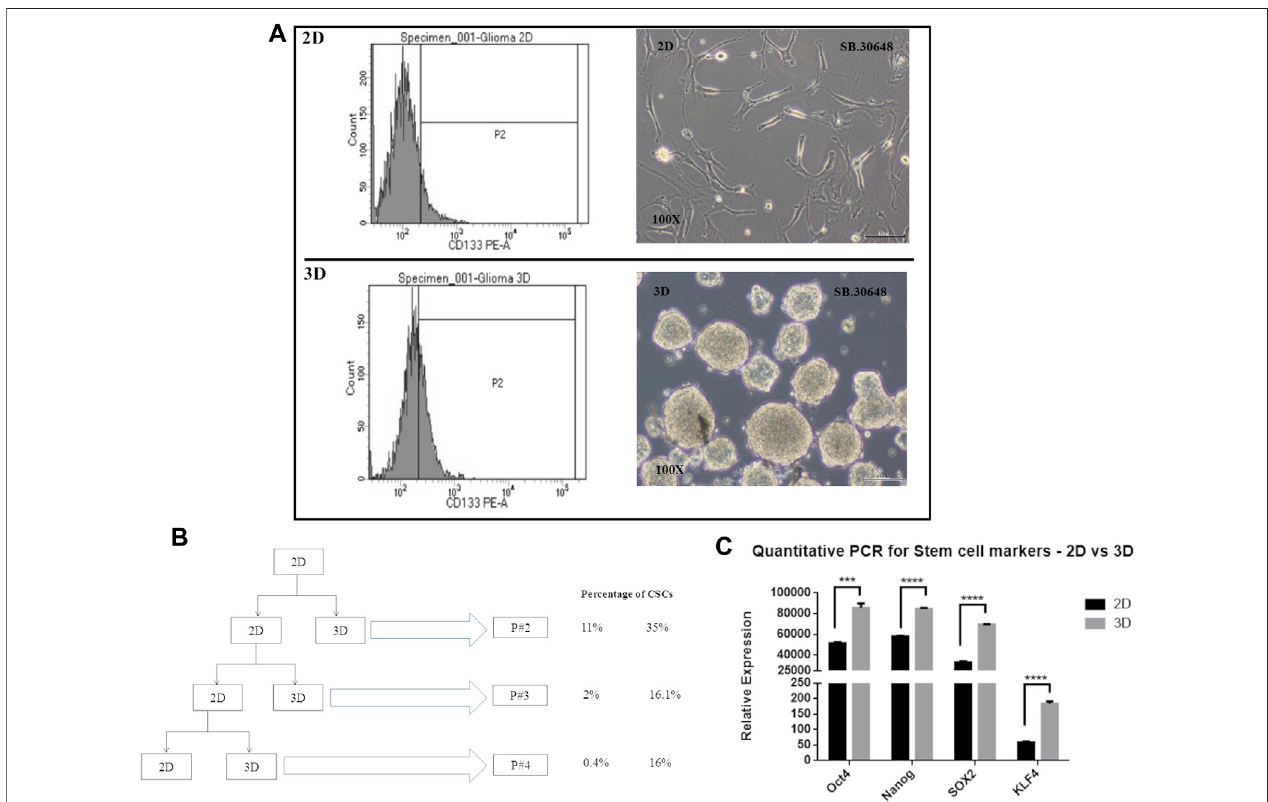
FIGURE 6 | Cancer stem cell determination in 2D vs. 3D cultures. (A) : CD133 positive staining detected by FACS at passage 2. (B) : Schematic showing the passaging of the DIG cells as 2D and 3D cultures and the percentage of CD133 positive cell sin successive passages. (C) : Quanti fi cation of stem cell markers, Oct4, Sox2, Nanog, and KLF4 in 2D monolayer cultures vs 3D spheroid cultures by RT-PCR. Student ’ s t test (two tailed) was used to determine the statistical signi fi cance of the marker expression between the 2D and 3D cultures. p value less than 0.05 was considered as signi fi cant (***) represents a p value less than 0.005 and (****) represents a p value less than 0.0001.